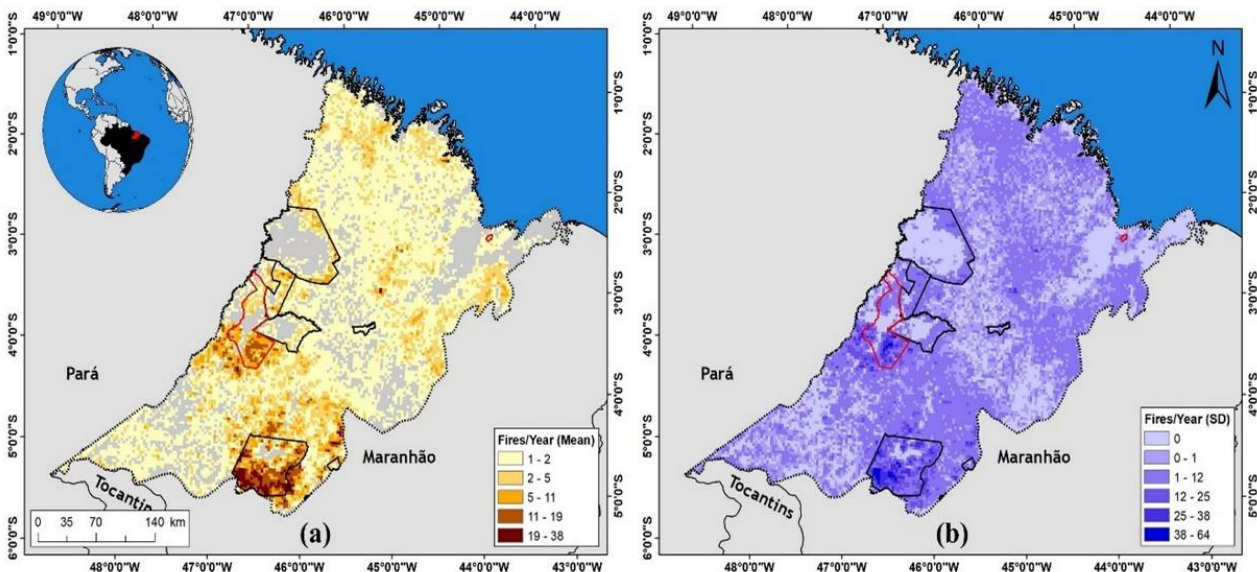
Figure 5. ( a ) Hot spot annual average for the 2012 – 2017 period in the Amazon region of Maranhão, Brazil. ( b ) Hot spot standard deviation for the period 2012 – 2017. We quantified active fires in pixels with 10-km spatial resolution.